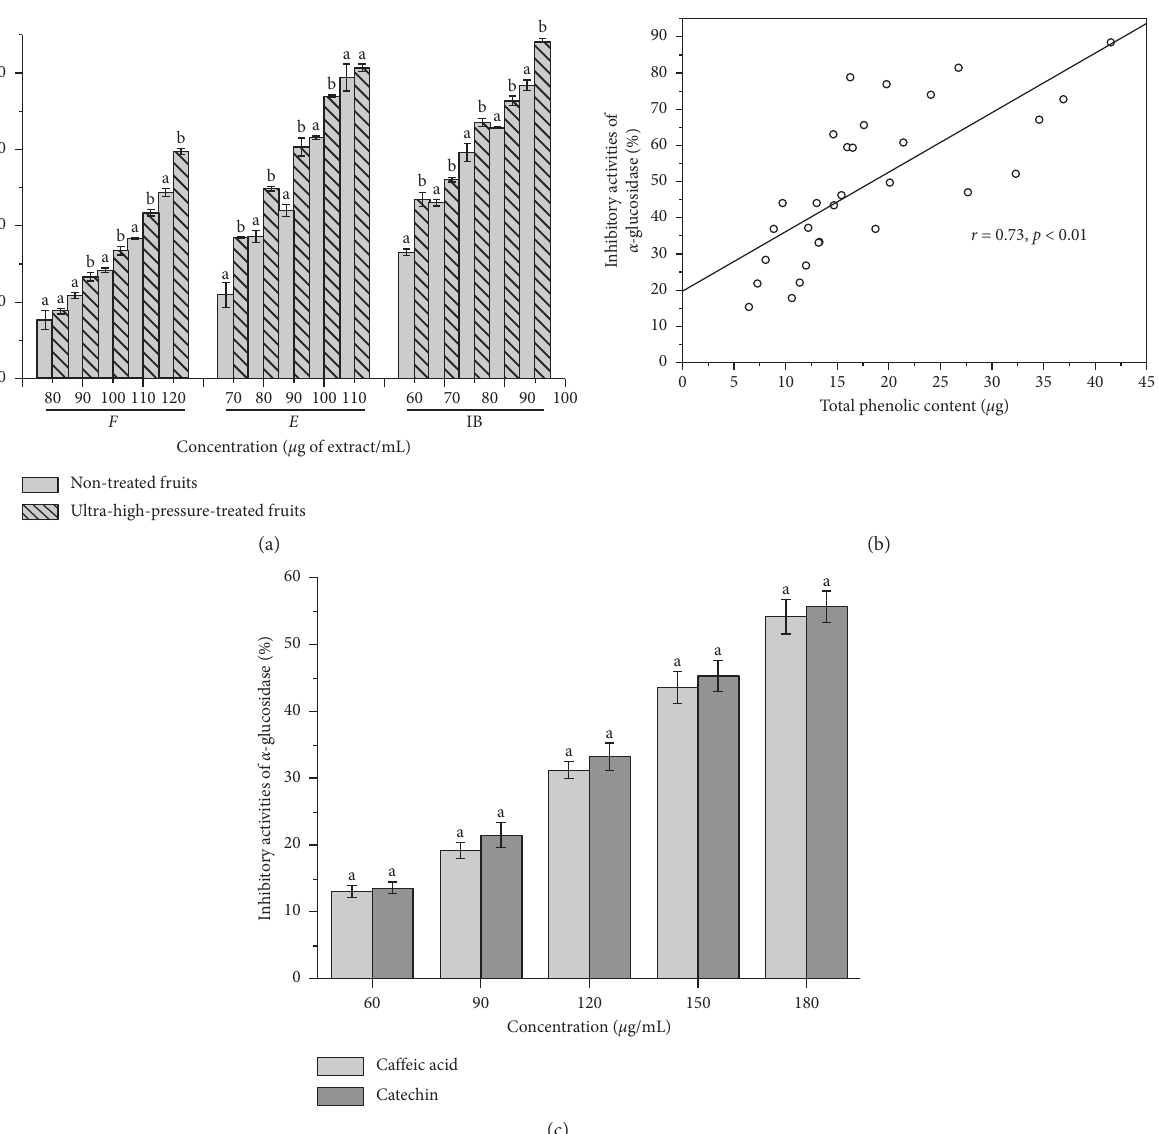
Figure 2: (a) The α -glucosidase inhibitory effects of free, esterified, and insoluble-bound phenolic fractions from nontreated and ultra-high- pressure-treated oil palm fruits. (b) The correlation analysis of TPC and α -glucosidase inhibitory effects. (c) Two main phenolic compound standards (catechin and caffeic acid). “ F ”: free phenolic fraction; “ E ”: esterified phenolic fraction; “IB”: insoluble-bound phenolic